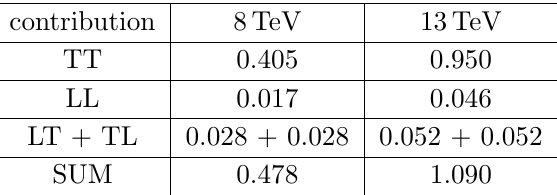
Table 2 . Contributions of di(cid:11)erent polarizations of W bosons for the inelastic-inelastic component for the LUX-like structure function. The cross sections are given in pb .